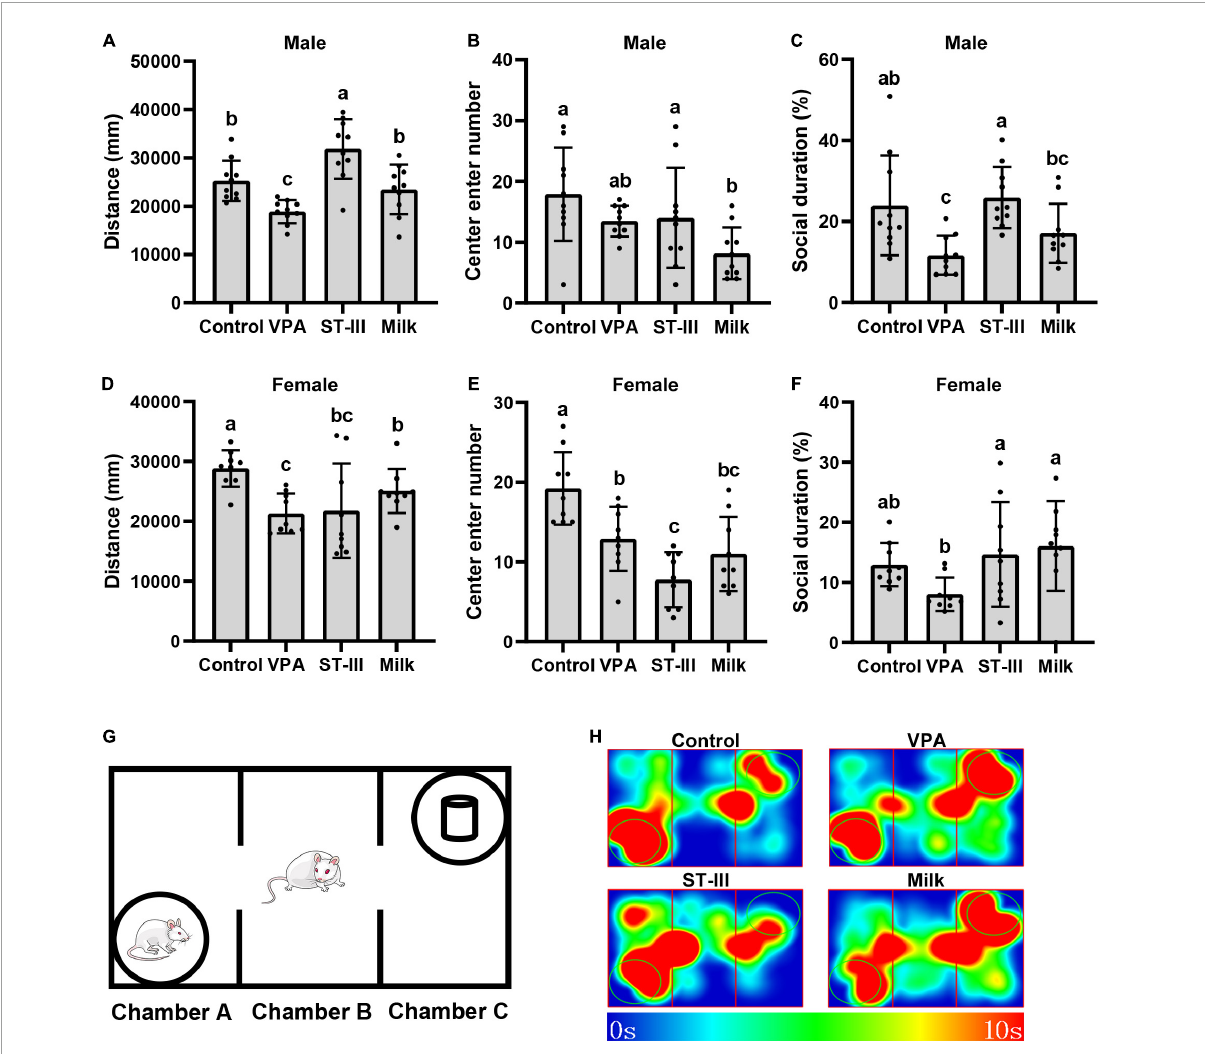
FIGURE1 Valproic acid (VPA) offspring mice exhibit autistic-like behavior abnormality, and administration treatment of Lactiplantibacillus plantarum ST-III-fermented milk ameliorates the behavior deficits. (A–C) Total movement distance, number of entering central area and social duration of male mice. (D–F) Total movement distance, number of entering central area and social duration of female mice. (G) Schematic of the three-chamber social test. (H) Thermodynamic diagram of male mice in three chamber social test. All data are expressed as mean ± standard deviation, and differences between groups are compared by one-way analysis of variance (ANOVA) with LSD or Duncan post-hoc analysis to correct for multiple comparisons. Differences were considered statistically significant when the p < 0.05. (a–c) Different superscript letters indicate statistically significant differences, and same superscript letters indicate statistically insignificant differences. n (male) = 10 per group, n (female) = 9 per